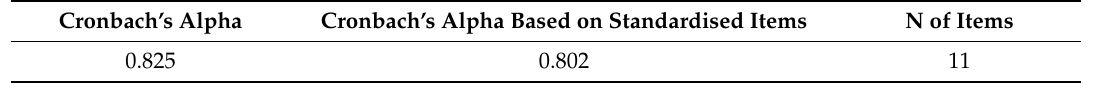
Table 7. Reliability Statistics.